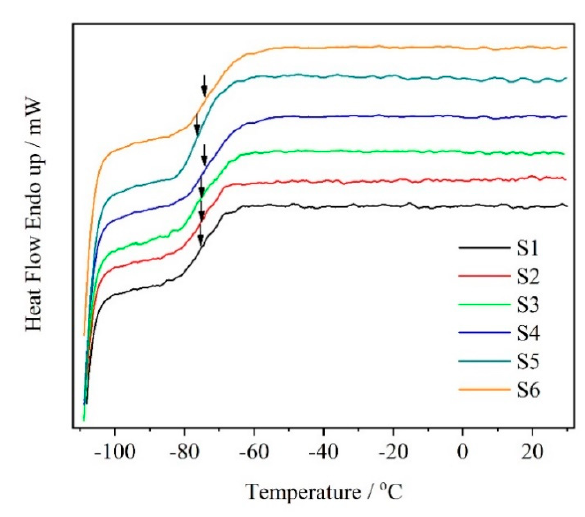
Figure 5. Di ff erential scanning calorimetric (DSC) curves for elastomers. Figure 5. Differential scanning calorimetric (DSC) curves for elastomers.